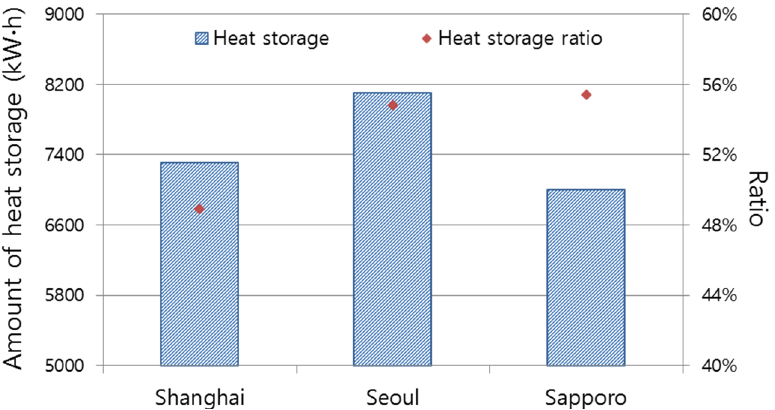
Figure 17. Simulation results of the stored solar heat and energy use ratio.